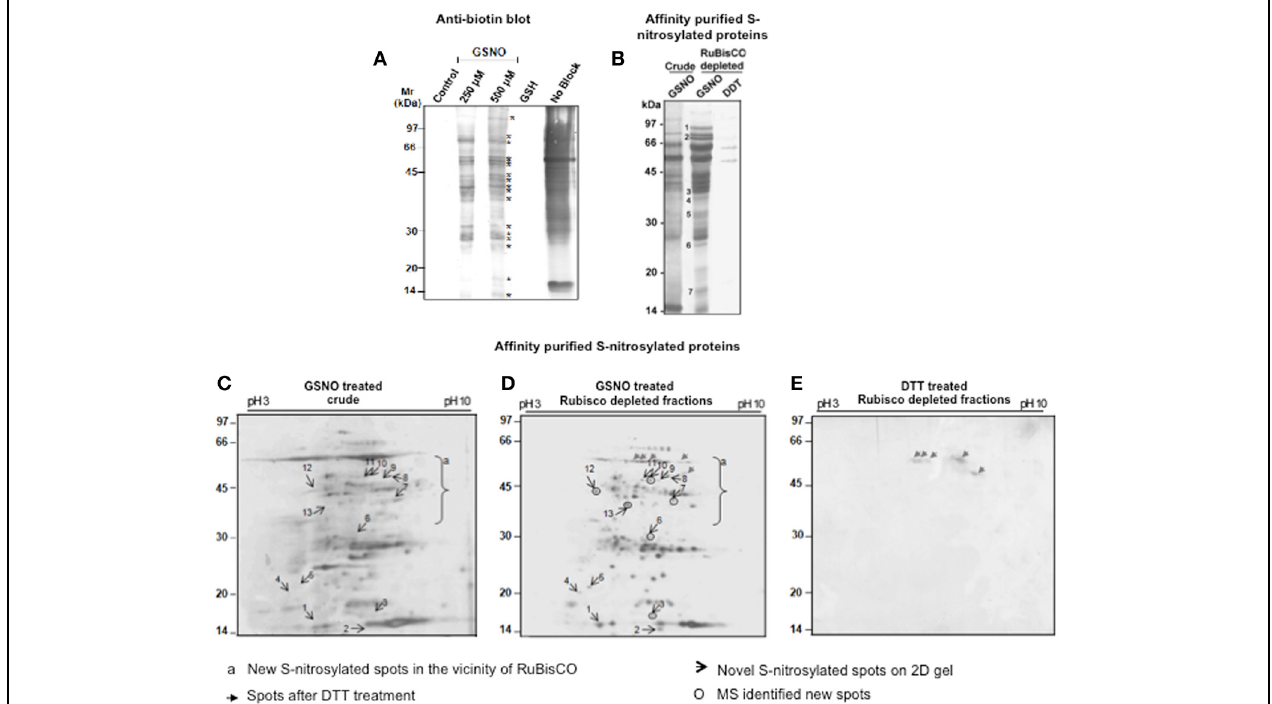
FIGURE 3 | Detection and purification of the S-nitrosylated proteins from the RuBisCO depleted fractions. (A) RuBisCO depleted extracts containing 250 µ g protein were treated with or without 250 µ M and 500 µ M GSNO or GSH (250 µ M) and labeled with biotin using biotin switch technique. Additionally, proteins without MMTS (no block) treatment served as a control for the blocking step. Proteins were resolved on a 12% SDS-PAGE gel and blotted onto nitrocellulose membrane. Biotinylated proteins are marked with asterisk ( ∗ ). (B) For the purification of the S-nitrosylated proteins, proteins (5mg) treated with GSNO (500 µ M) were subjected to biotin switch